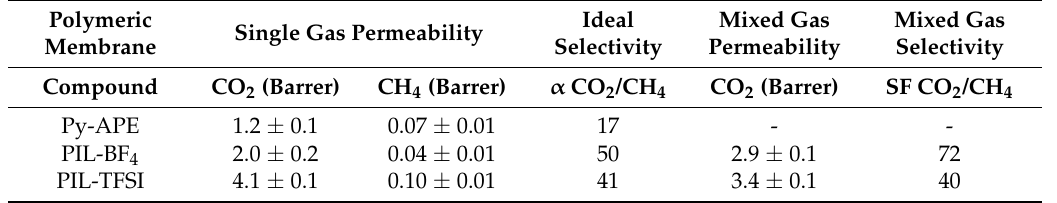
Table 2. Separation performance of the prepared polymer precursor Py-APE, PIL-BF 4 and PIL-TFSI